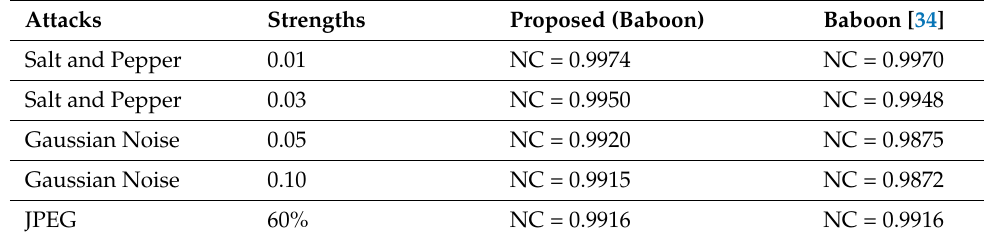
Table 9. Normalized correlation against image processing attacks.